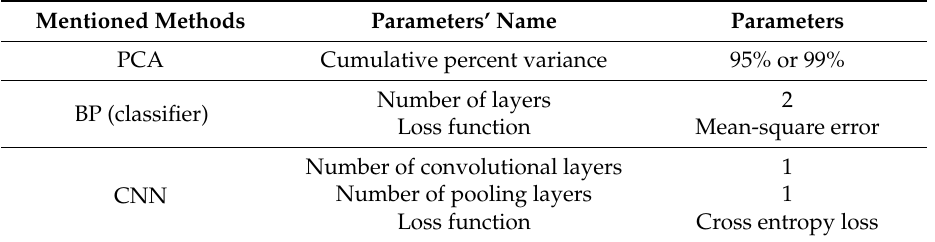
Table 5. The parameters of the whole system.